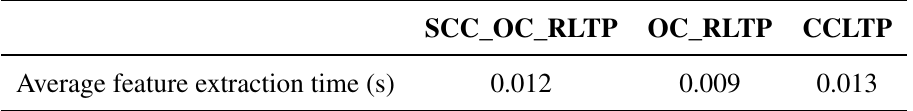
Table 3. The average feature extraction time per image on